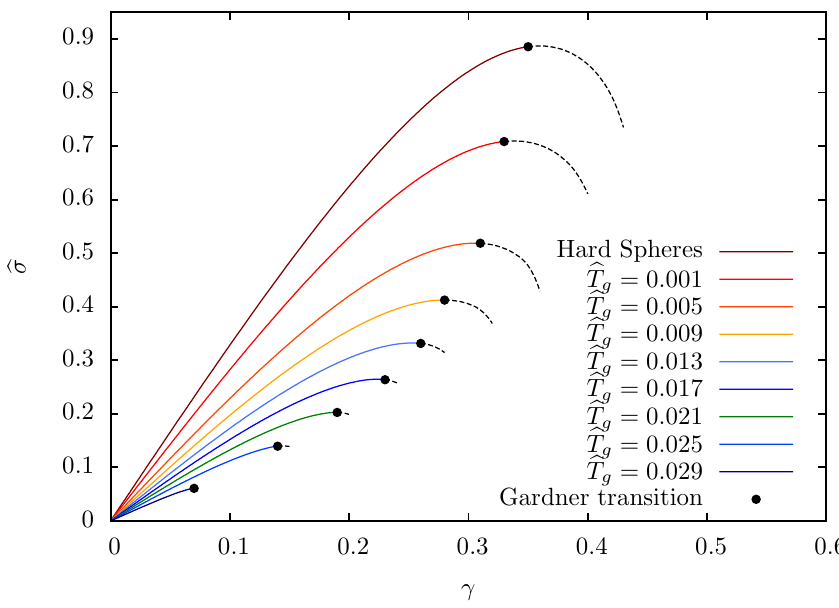
ϕ = 6, ) and followed (cid:98) T g (cid:98) g